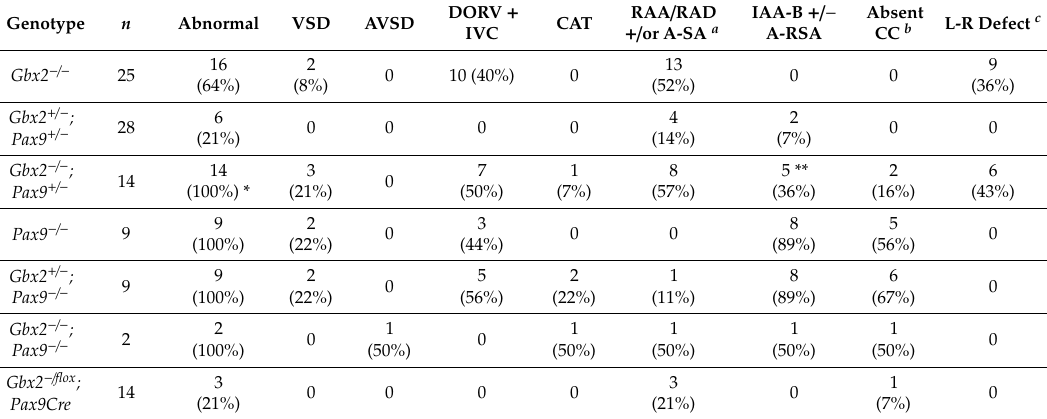
Table 1. Number of cardiovascular defects observed in Gbx2;Pax9 mutant